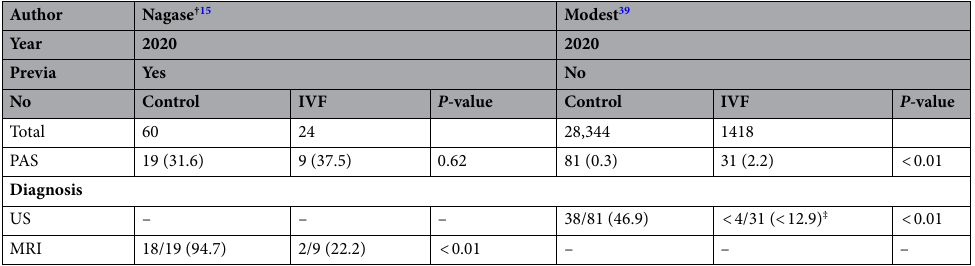
Table 2. Diagnostic accuracy of PAS after IVF-ET. The numbers (percentages per column) are shown. †